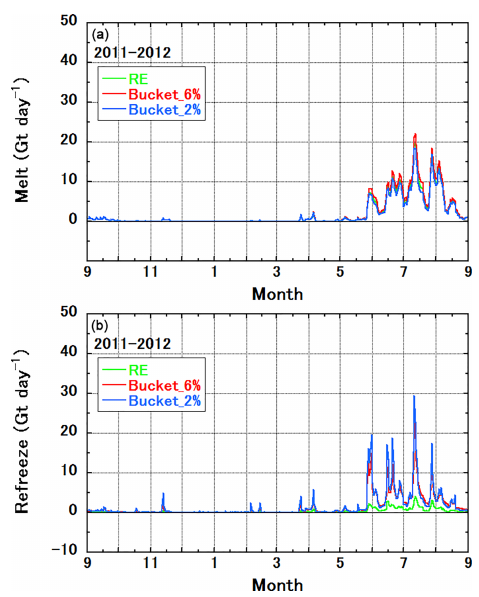
Figure 9. Sensitivity to the choice of vertical water movement scheme of the simulated top 30m integrated (a) melt and (b) re- freeze rates for the GrIS during the 2011–2012 mass balance year. RE indicates the default setting for vertical water movement in snow and firn based on the Richards equation; Bucket_6% and Bucket_2% are alternative settings based on simple bucket schemes with irreducible water contents of 6 and 2% of the pore